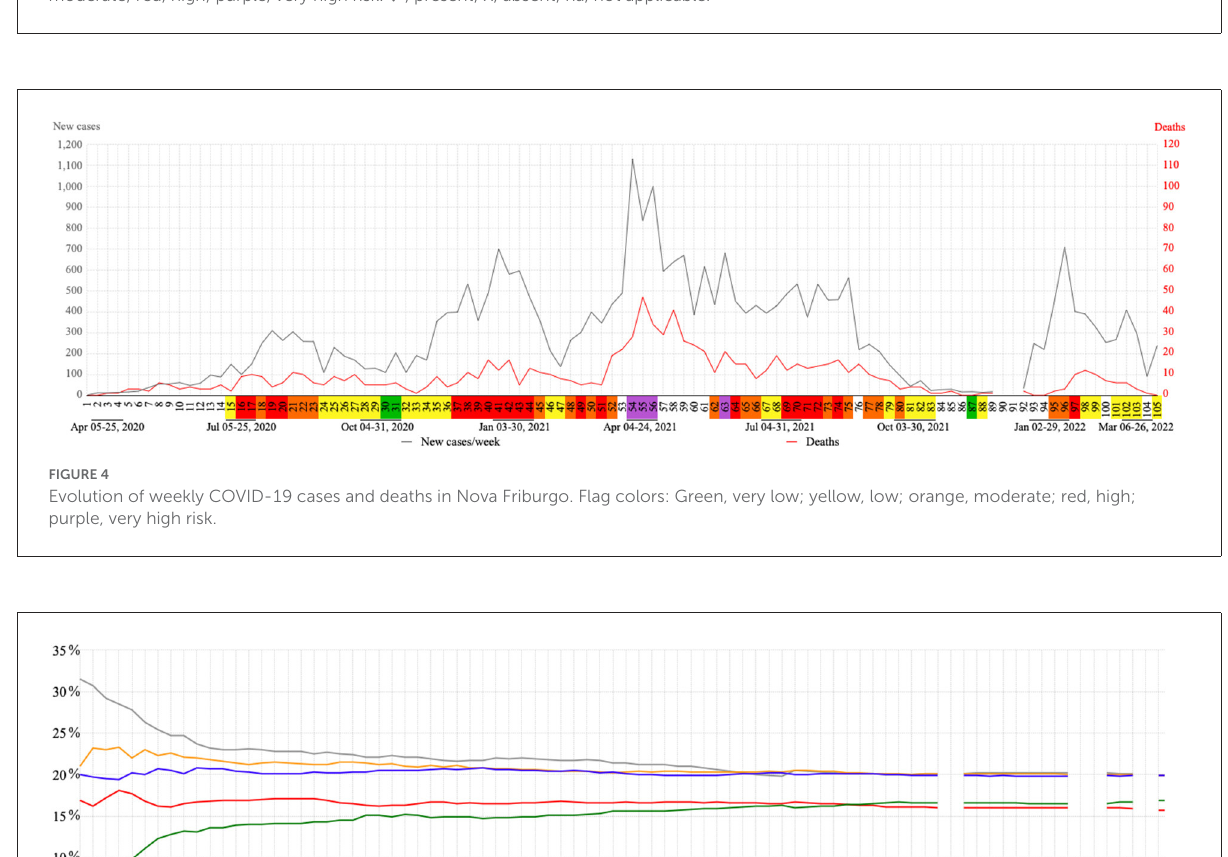
FIGURE3 State color flag system for all 16 cities of the mountainous region and for this entire region of the state of Rio de Janeiro. Cities: 1, Petrópolis; 2, Nova Friburgo; 3, Teresópolis; 4, Guapimirim; 5, Cachoeiras de Macacu; 6, Bom Jardim; 7, Cordeiro; 8, São José do Vale do Rio Preto; 9, Cantagalo; 10, Carmo; 11, Sumidouro; 12, Duas Barras; 13, Trajano de Moraes; 14, Santa Maria Madalena; 15, São Sebastião do Alto; 16, Macuco; *City where this study was conducted. Flag colors: gray, unknown (absent or not found); green, very low; yellow, low; orange, moderate; red, high; purple, very high risk. X , present; X, absent; na, not applicable.